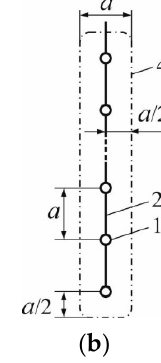
Figure 1. Multiple earthing system with vertical electrodes (VEG) with vertical electrodes placed after a straight line: ( a ) partial section, with the main characteristic dimensions; ( b ) footprint; 1—electrode; 2—connecting conductor; 3—the soil; 4—footprint contour on the ground.